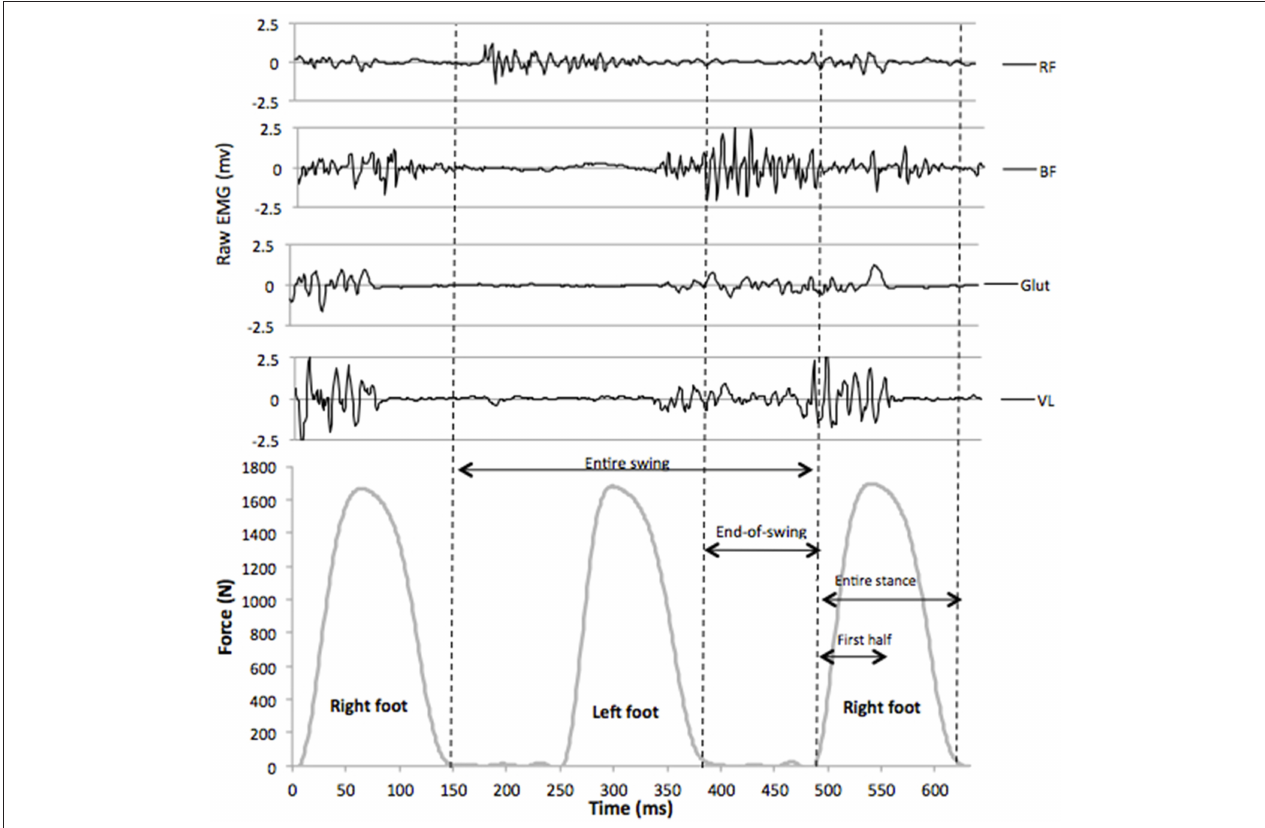
FIGURE 1 | Raw EMG signals for vastus lateralis (VL), gluteus maximus (Glut), biceps femoris (BF), and rectus femoris (RF) muscles, synchronized with vertical GRF during a typical sprint stride (7th stride of a maximal 6-s acceleration). The following phases for EMG analysis were determined from vertical GRF data (30 N threshold): entire swing, end-of-swing, entire stance, and first half of the stance.